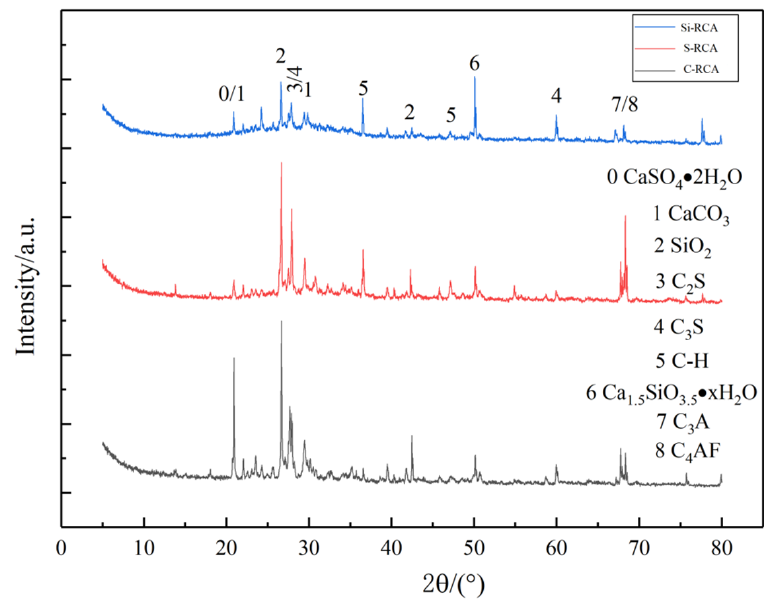
Figure 7. X-ray diffraction (XRD) pattern of RCA before and after modification.